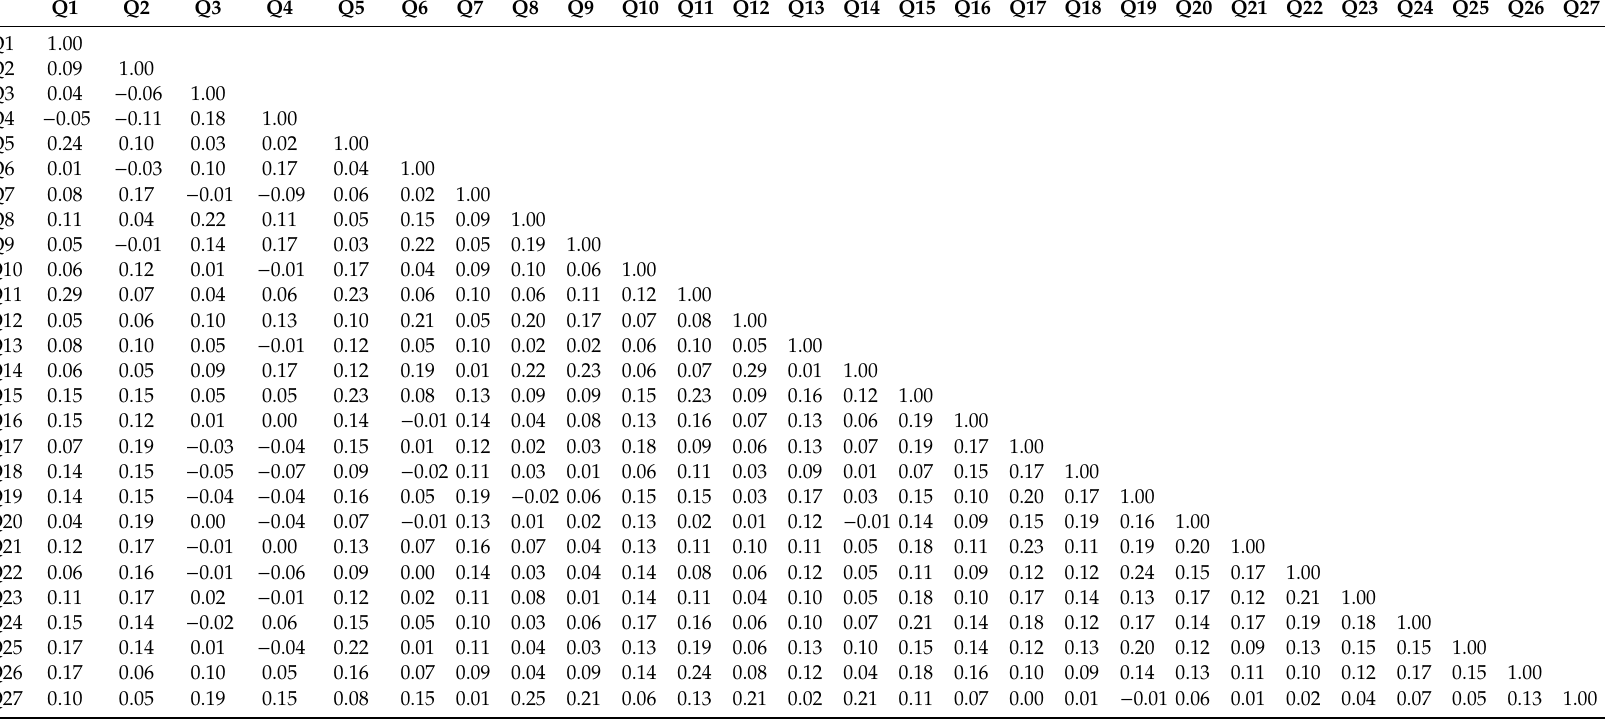
Table A2. Correlation between each item of the sexually transmitted disease knowledge